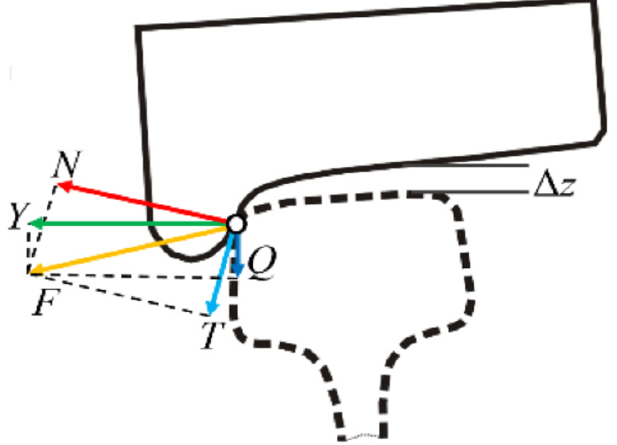
Figure 3. Force components in wheel-rail contact in the event of excessive wheel climbing on the rail ( Y —transverse force, Q —vertical force, N —normal force, T —friction force, F —lateral rolling friction force, Δ z —wheel lift).